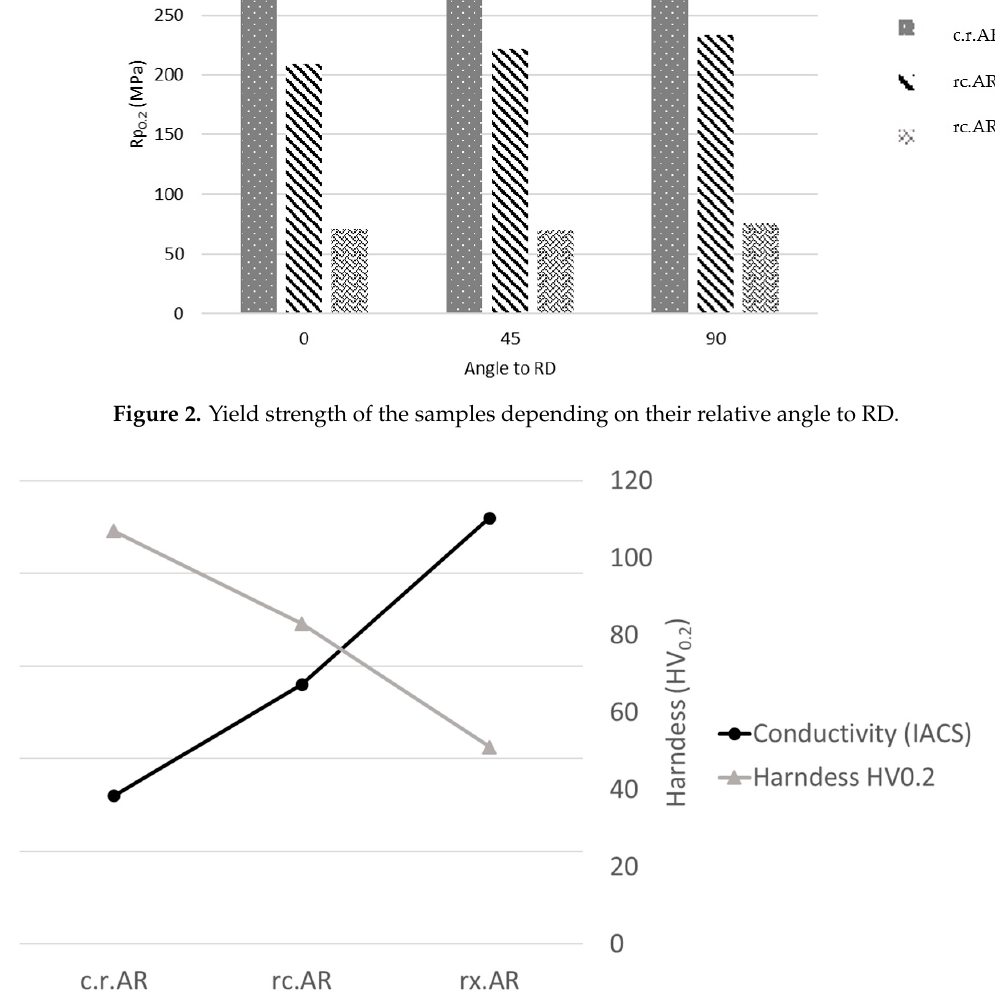
Figure 2. Yield strength of the samples depending on their relative angle to RD.